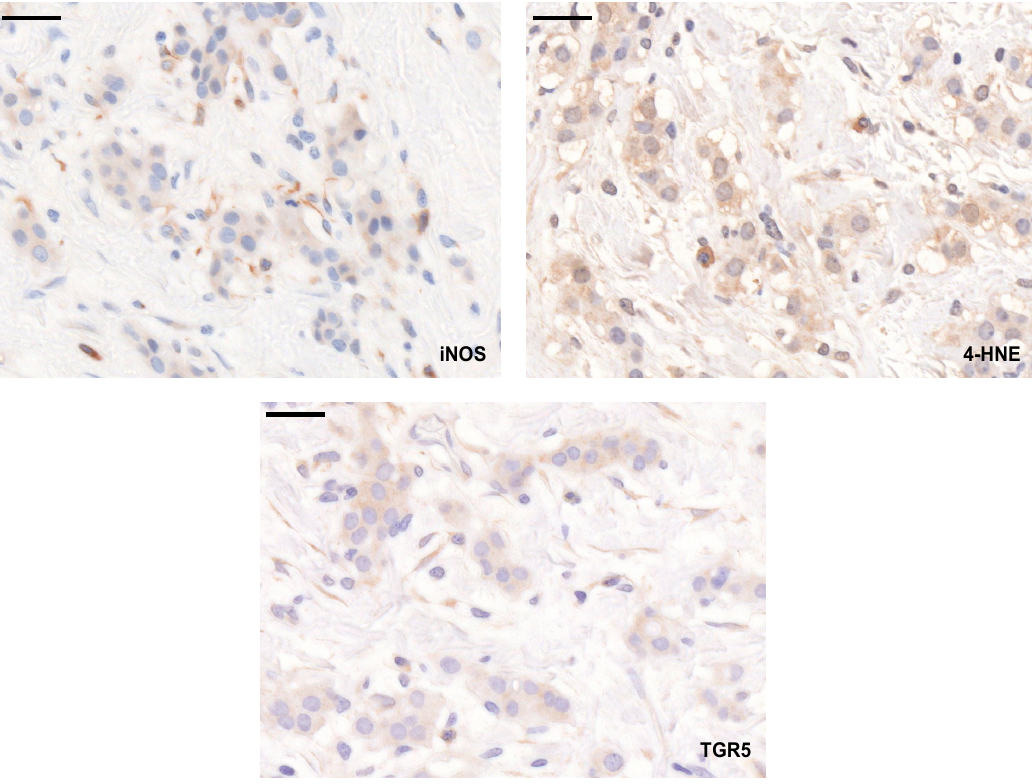
Figure 11. Staining pattern of the antibodies used in the study. Breast cancer specimens in a TMA were stained with the antibodies indicated, and the immune reactions were developed using DAB. The black line indicates 50 µm.